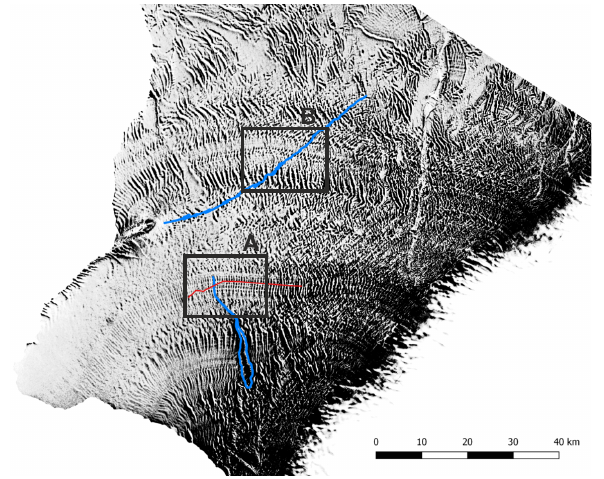
Figure 11. Map showing radar backscatter proxy for the presence of meteoric ice. Over most of the ice shelf, black indicates the presence of meteoric ice, and white areas correspond to infill by sea ice and firn. Boxes indicate the location of detailed views in Figs. 12 and 13. Red line is the location of the profile in Fig. 10.